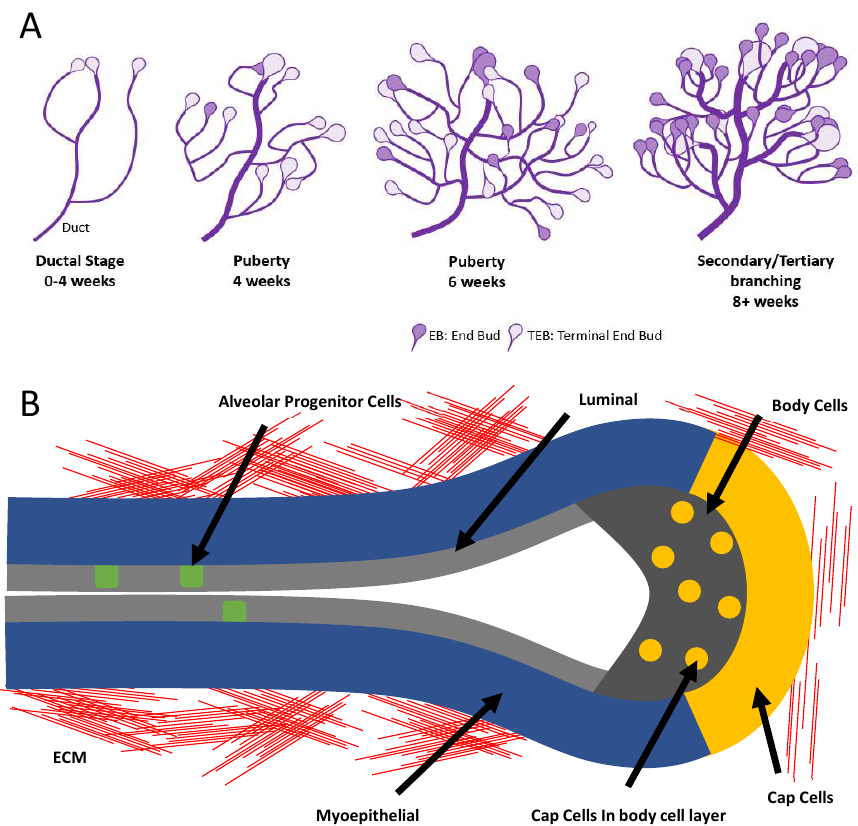
Figure 1. ( A ) Schematic of mammary gland development over the course of puberty ( B ) Terminal End Bud (TEB) structure, identifying the structure and types of cells present.